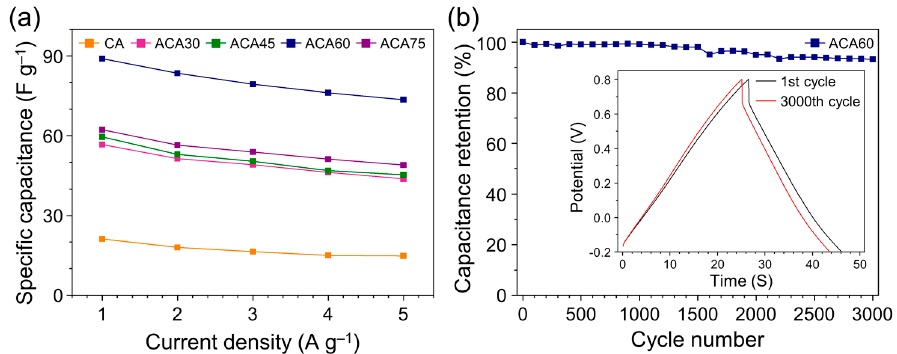
Figure 7. ( a ) Comparison of specific capacitances of CA and ACA samples and ( b ) cycle performance of ACA60 electrode at a current density of 3 A g − 1 over 3000 cycles (inset: GCD curves for 1st and 3000th cycle).